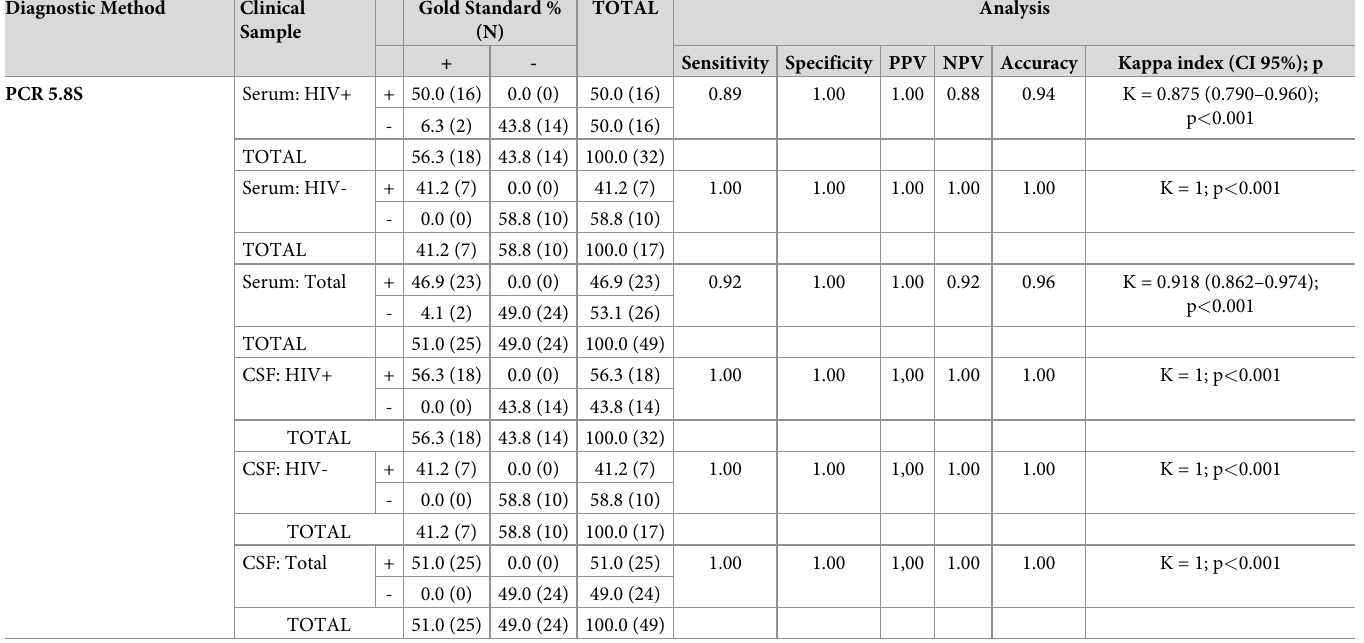
The 18S PCR assay results in HIV-positive patients were similar for both serum (K = 0.566; 0.423–0.709; p = 0.001) and CSF (K = 0.552; 0.403–0.701; p = 0.002), and agreement was only moderate. The Kappa index for the HIV-negative patients was 0.746; (0.583–0.909; p = 0.001) for serum and 0.876 (0.757–0.995; p < 0.001) for CSF, and agreement was substantial. Compar- ative analysis of serum samples did not demonstrate a difference between the 18SrDNA PCR and latex agglutination assays. These results demonstrate that latex agglutination can detect early stage Cryptococcus spp. In CSF samples from HIV-positive patients, the 18S PCR demon- strated a better performance in terms of sensitivity. The latex agglutination test was the most specific, but the 18S PCR had a high sensitivity, and can be used as a complementary test. The CSF samples showed a higher accuracy (0.94) and a kappa index (0.876; 0.757–0.995; p < 0.001) in the HIV-negative patients with a high level of agreement with the culture gold standard. The 5.8S PCR assay demonstrated a high degree of accuracy in CSF samples from both HIV-positive and -negative patients. Analysis of the corresponding serum samples revealed a comparatively lower sensitivity and NVP, despite both having an almost perfect agreement (Kappa index 1; p < 0.001 for CSF and 0.918 (0.862–0.974); p < 0.001 for serum). In order to select a highly accurate methodology for the diagnosis of Cryptococcosis, we compared the results obtained by analysis of the 18S and 5.8S PCR-generated DNA sequences with results of the latex agglutination test and India ink staining. The 5.8S primers showed 100% specificity for detection of Cryptococcus sp. Comparing the India ink results with the 18S and 5.8S PCR assays, the genomic methods were the most sensitive for detection of Cryptococ- cus spp. both in CSF and serum. Regarding specificity, no difference was observed between the analysis using India ink and the 5.8S PCR primers. In contrast, the 18S PCR showed a lower specificity compared to India ink